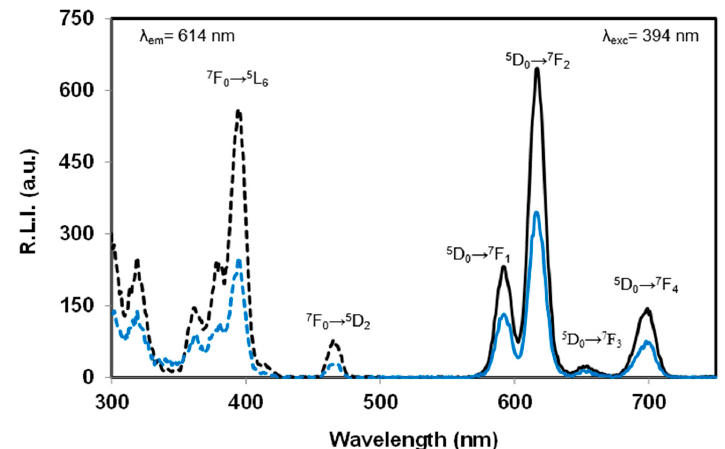
Figure 5. Excitation (dashed line) and emission (solid line) spectra of Eu:cit-cAp nanocarriers free of Doxo (black color) and loaded with 0.037 mg Doxo / mg Eu:cit-cAp (blue color) suspended in water at 25 ◦ C and pH = 7.4. Slit-widths exc / em = 10 / 10 nm, td = 120 µ s, t g = 5 ms, detector voltage 800 V. λ exc = 394 nm; λ em = 614 nm.